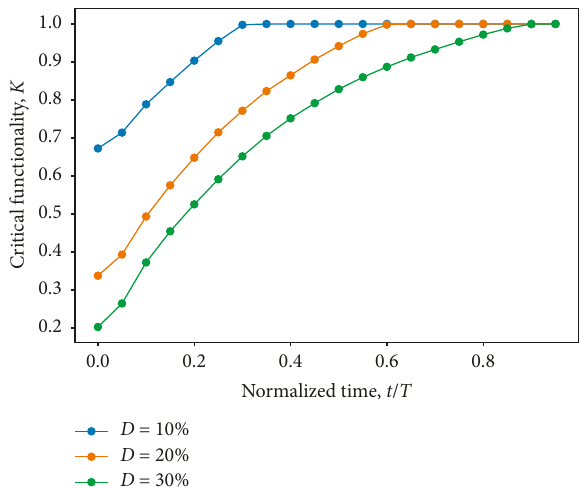
Figure 5: Performance of random recovery strategy for disruption percentage of 10%, 20%, and 30%. This result shows the impact of initial damage to the system. Initial damage of 30% can cause the drop of system performance to be as low as 0.2.